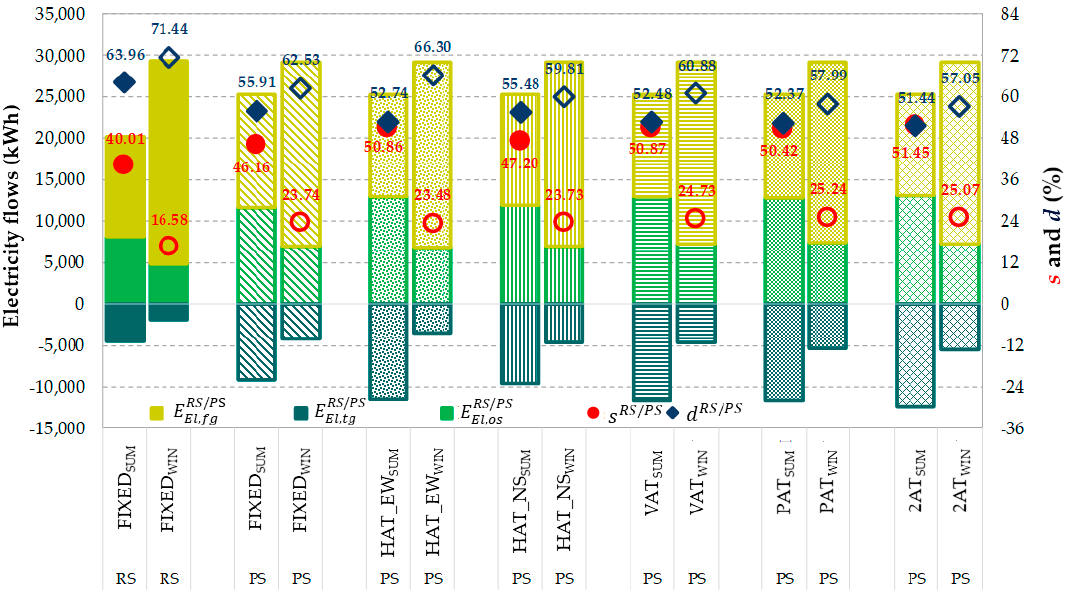
Figure 8. Primary energy demand of RS and PS, PFES index in Scenario_YV. This approach is often adopted in literature and it can prejudice the results. Indeed, the energy benefits achieved by using PS instead of RS (in all configuration) are underestimated if Scenario_YV is considered instead of Scenario_MV. For instance, PFES in summer (SUM) for the case in which the panels rotate from East to West around a tilted axis (PAT case), decreases from 88.93% (in